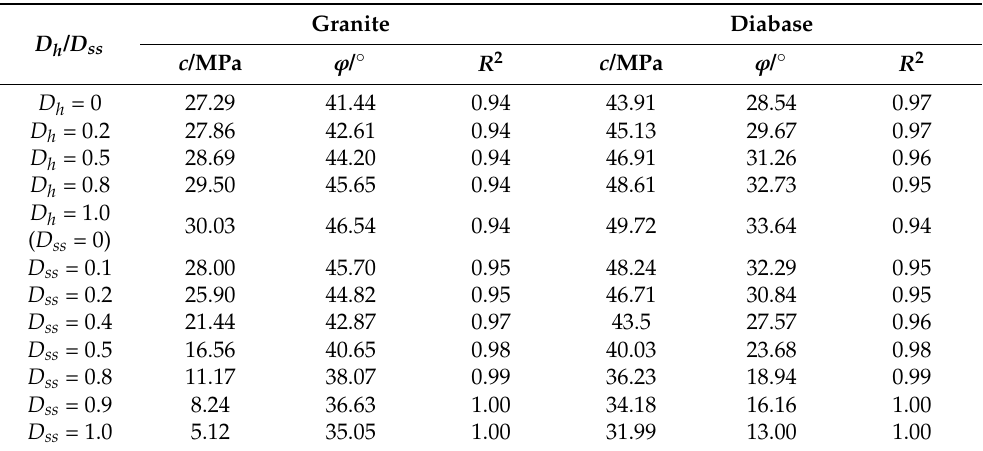
Table 2. The cohesion c and internal friction angle ϕ values corresponding to each hardening and softening factor (Beishan granite [26] and Danjiangkou diabase [37]). Granite Diabase D h / D ss c